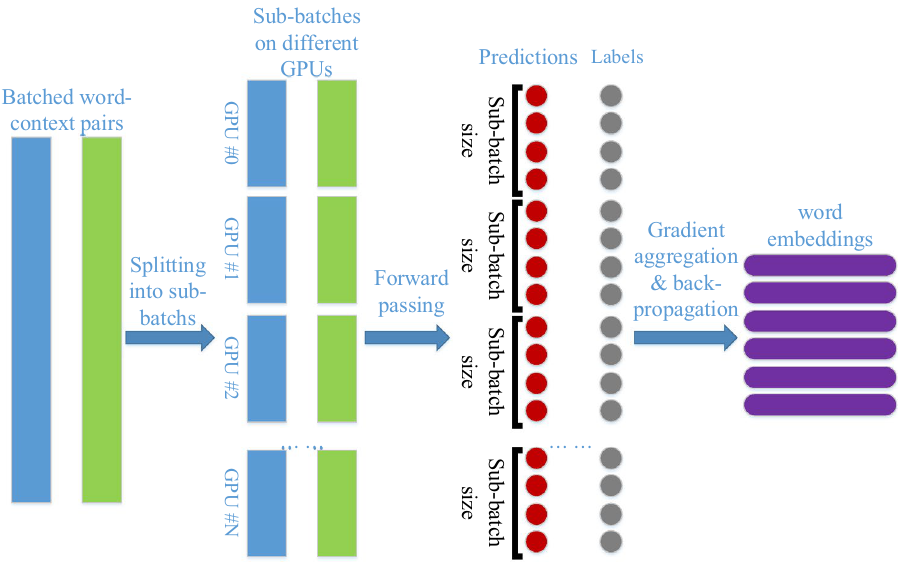
Fig. 9 Illustration of data paral- lelism with